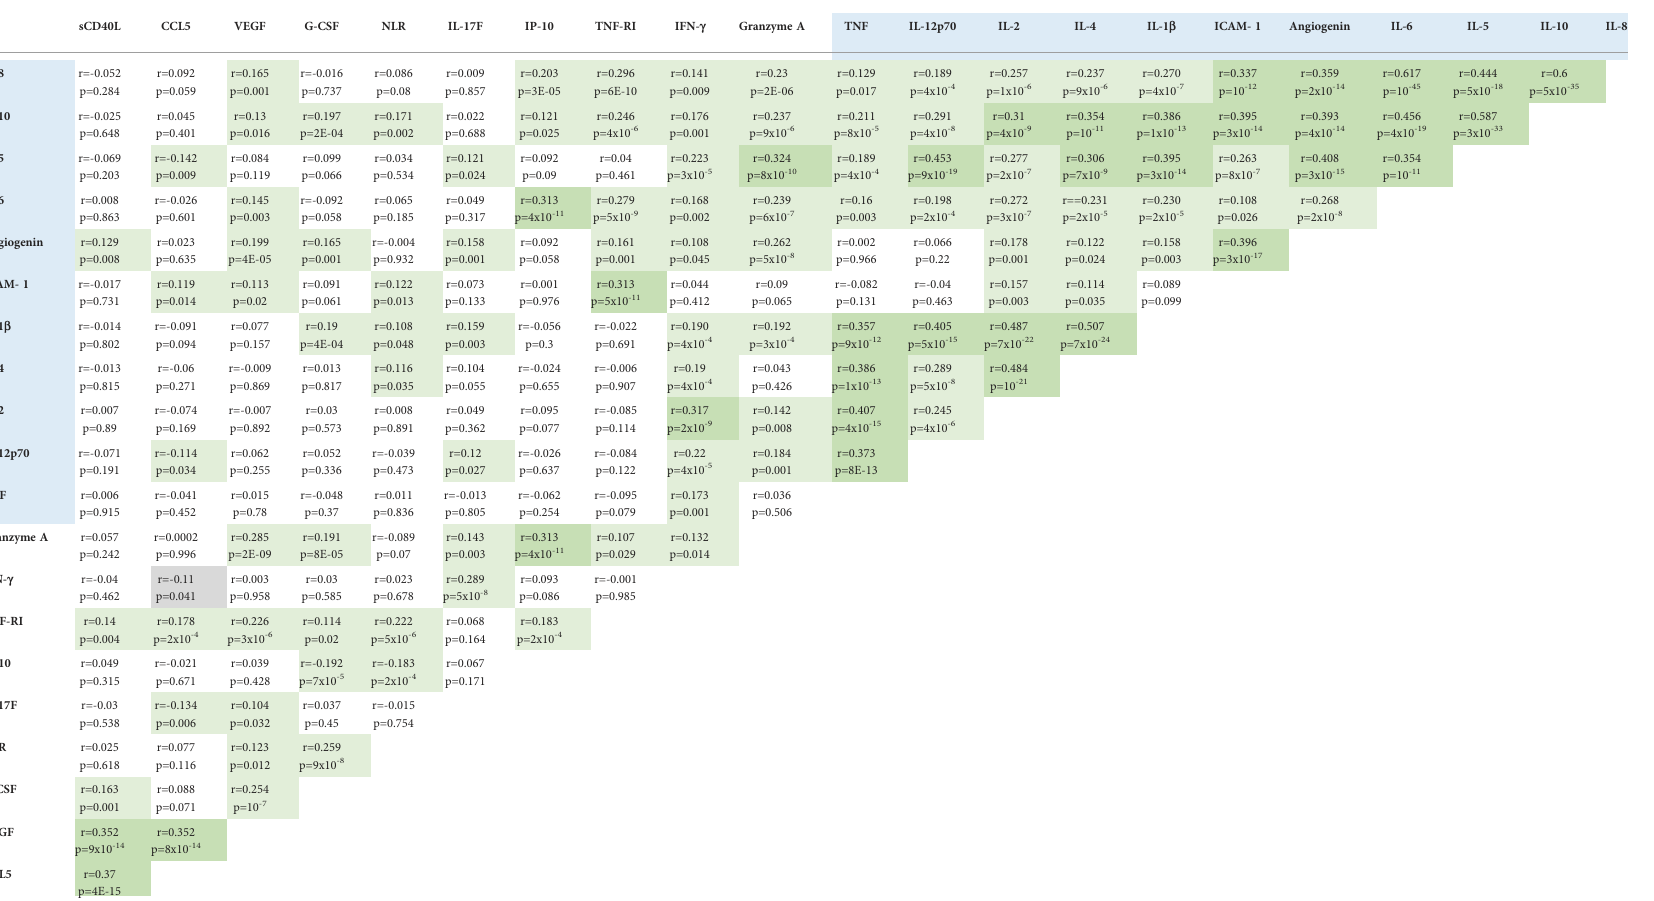
TABLE 3 Overview of the associations between blood cytokine levels and patient